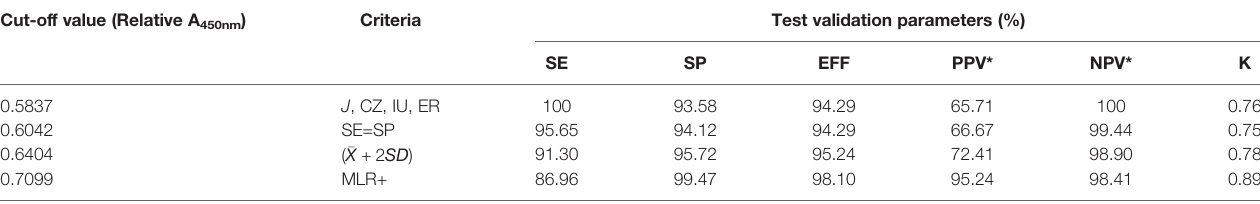
TABLE 1 | Performance of Scedosporium boydii speci fi c IgG at different cut-off values with 25 serum samples of Cystic Fibrosis patients with Scedosporium / Lomentospora positive sputum cultures and 190 negative sera. Cut-off value (Relative A 450nm ) Criteria